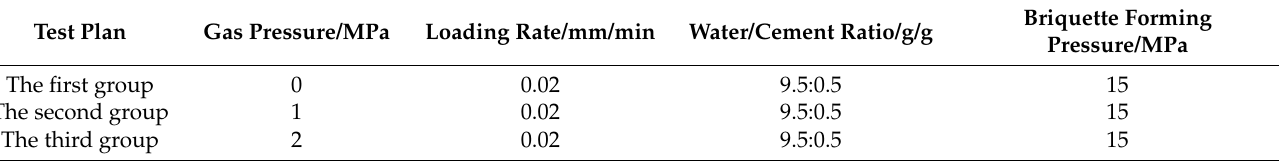
Table 1. Uniaxial compression test scheme of gas-containing coal.